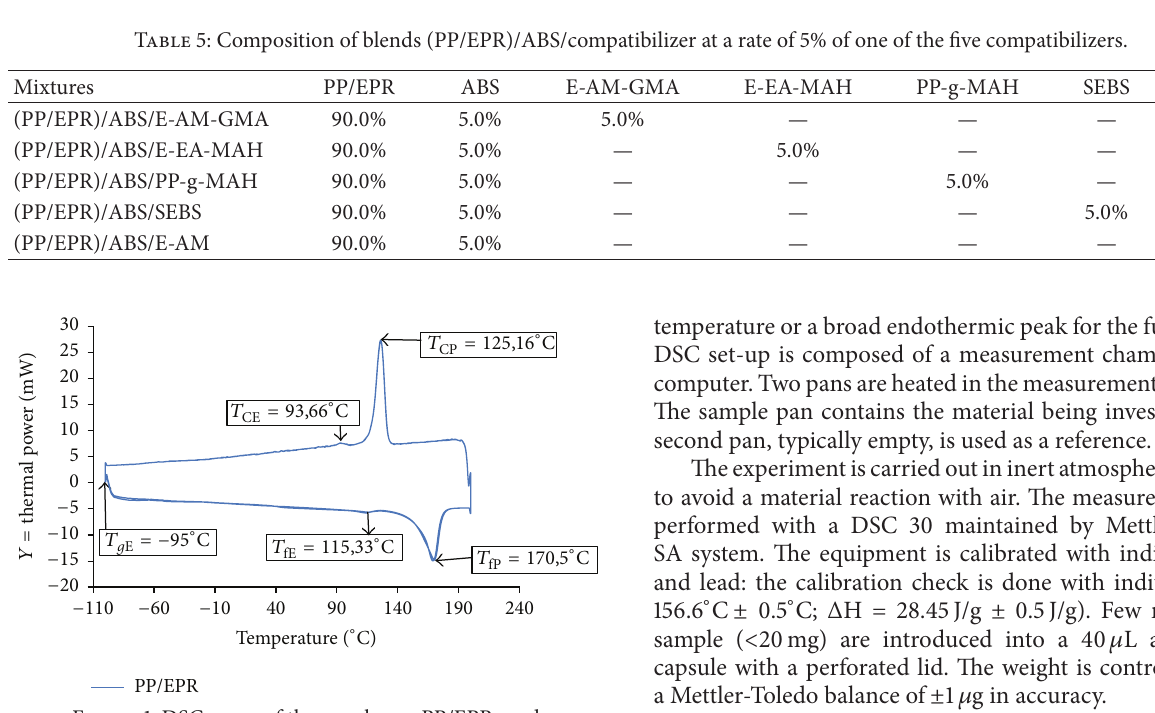
Figure 1: DSC curve of the copolymer PP/EPR used.